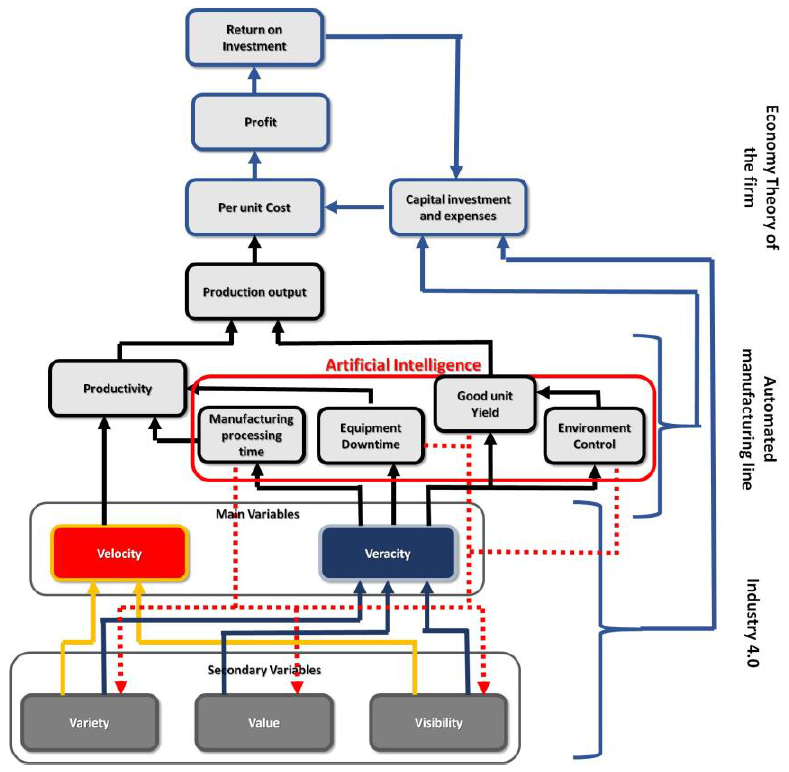
Fig. 3. Model of Industry 4.0 ROI